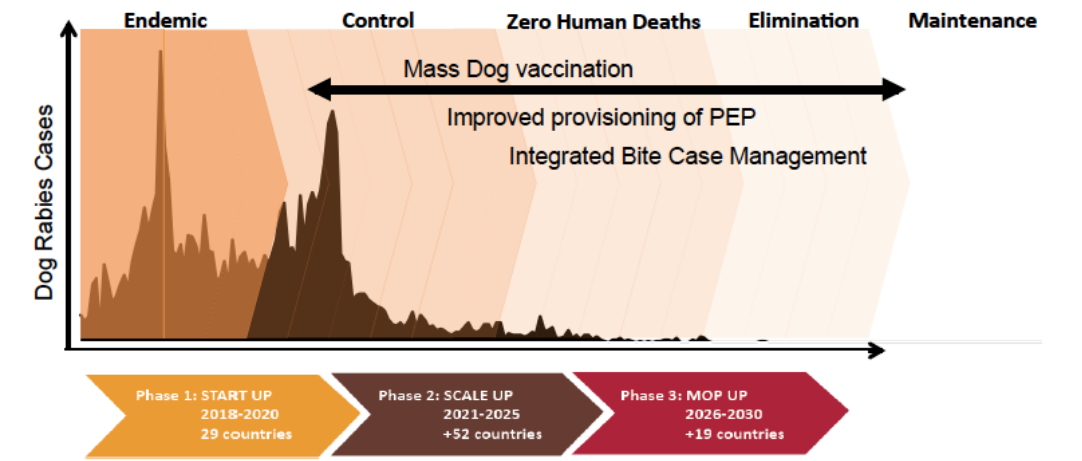
Figure 1. Interventions to reach the Zero by 30 target. PEP, post-exposure